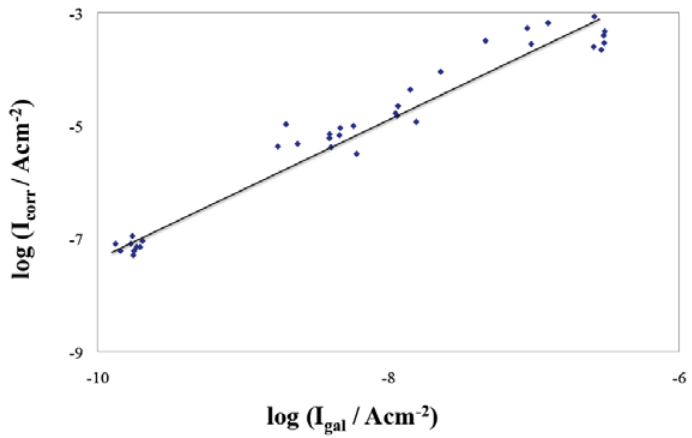
vs. log I gal corr